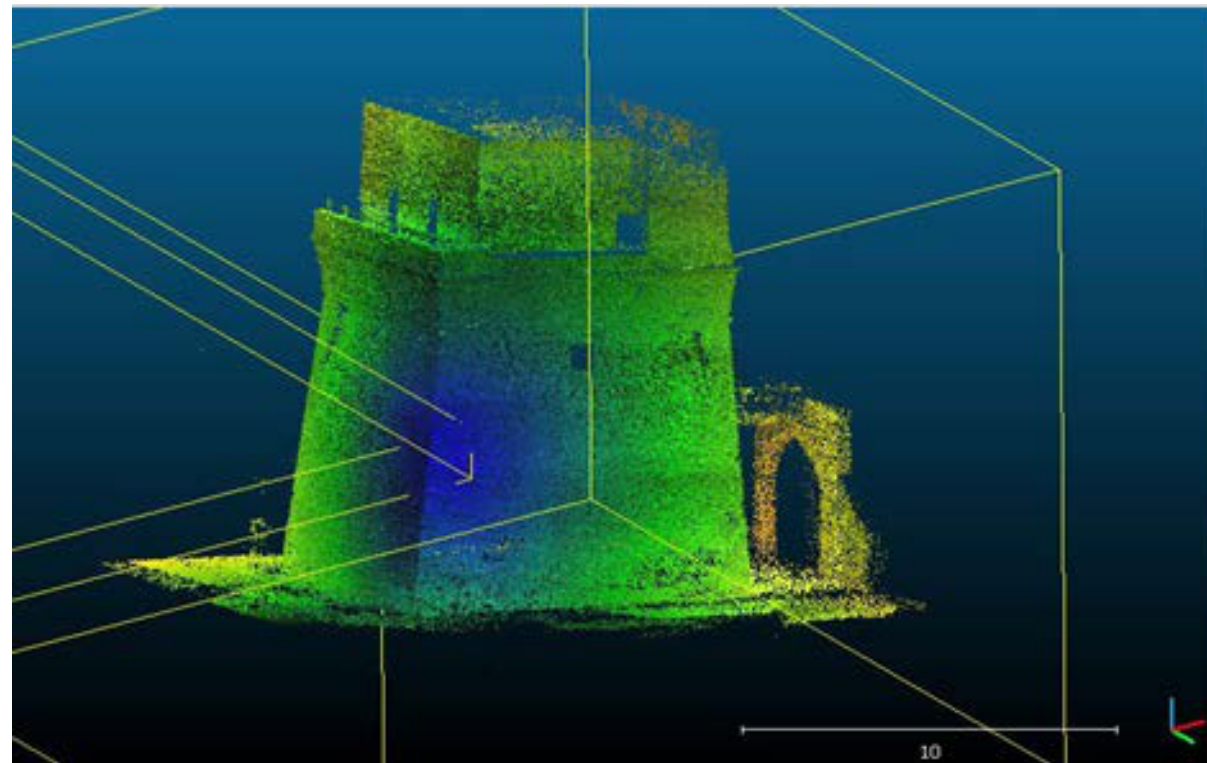
Figure 12: Cloud points comparison using CloudCompare (blue: minimum deviation; yellow: maximum